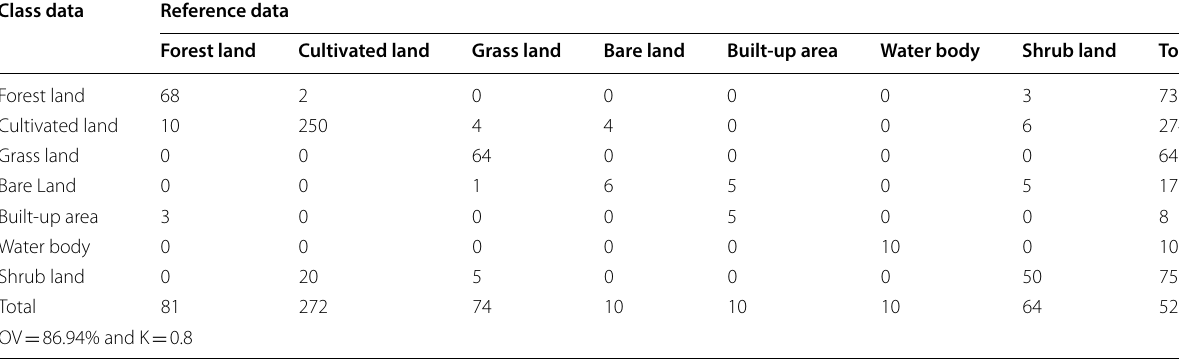
Table 3 Accuracy Assessment result using confusion